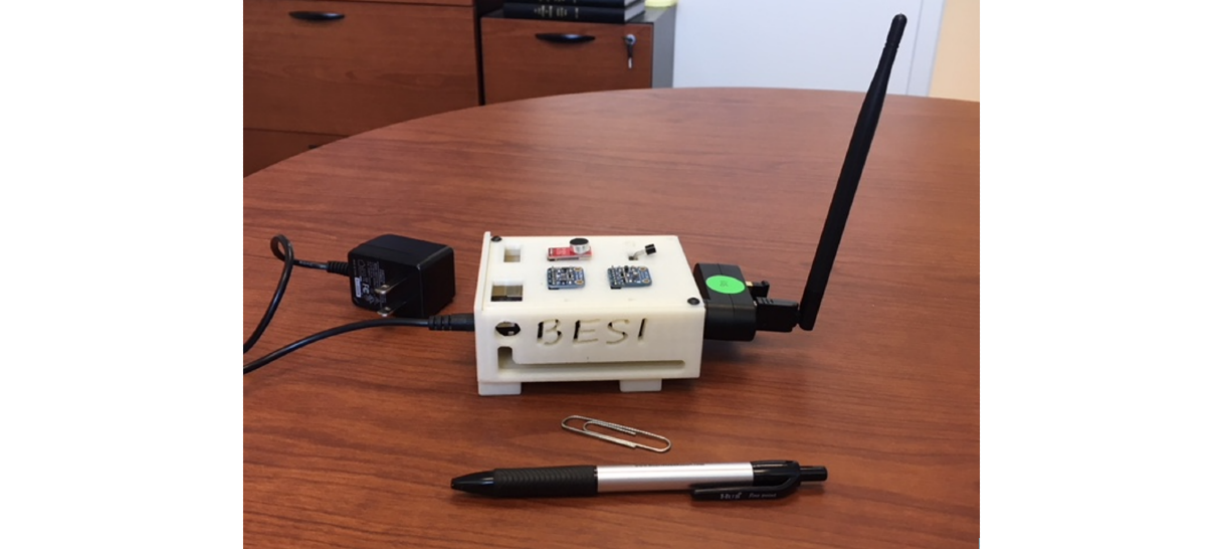
Figure 2. Behavioral and Environmental Sensing and Intervention for Cancer (BESI-C) initial environmental sensor.